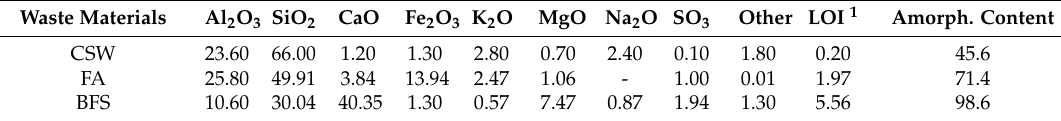
Table 4. Chemical composition and amorphous content of CSW, BFS, and FA (wt %).